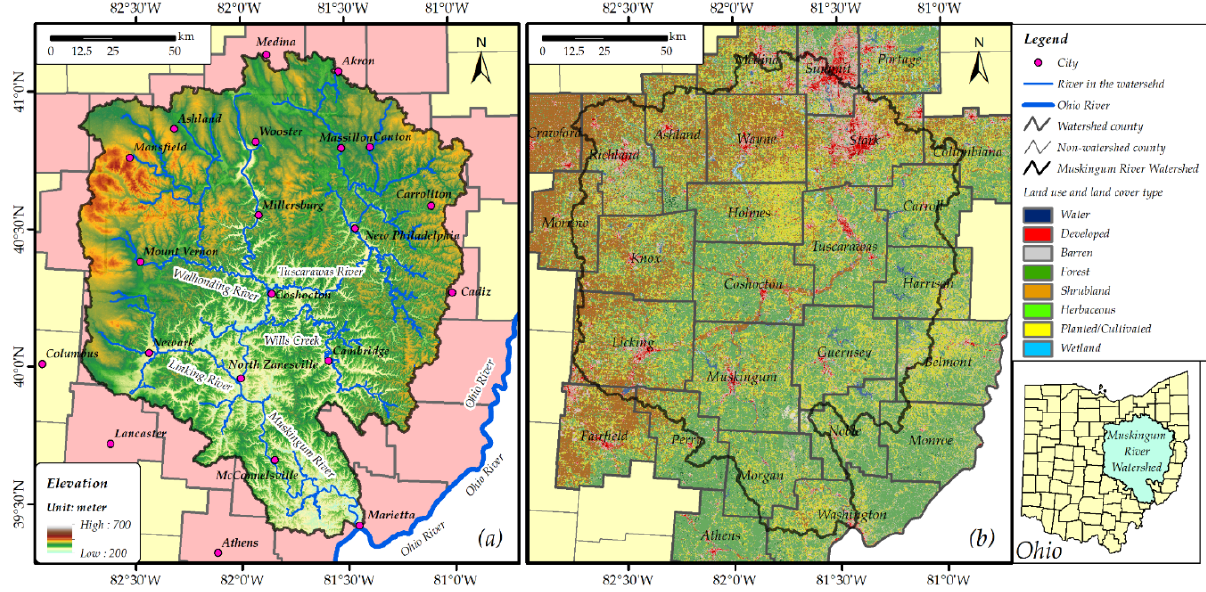
Figure 3. Geographic settings of the study area: ( a ) topography and main rivers, obtained from the United States Geological Survey (USGS) National Elevation Dataset (NED); ( b ) landcover and land use map, derived from the National Land Cover Database (NLCD) 2016.